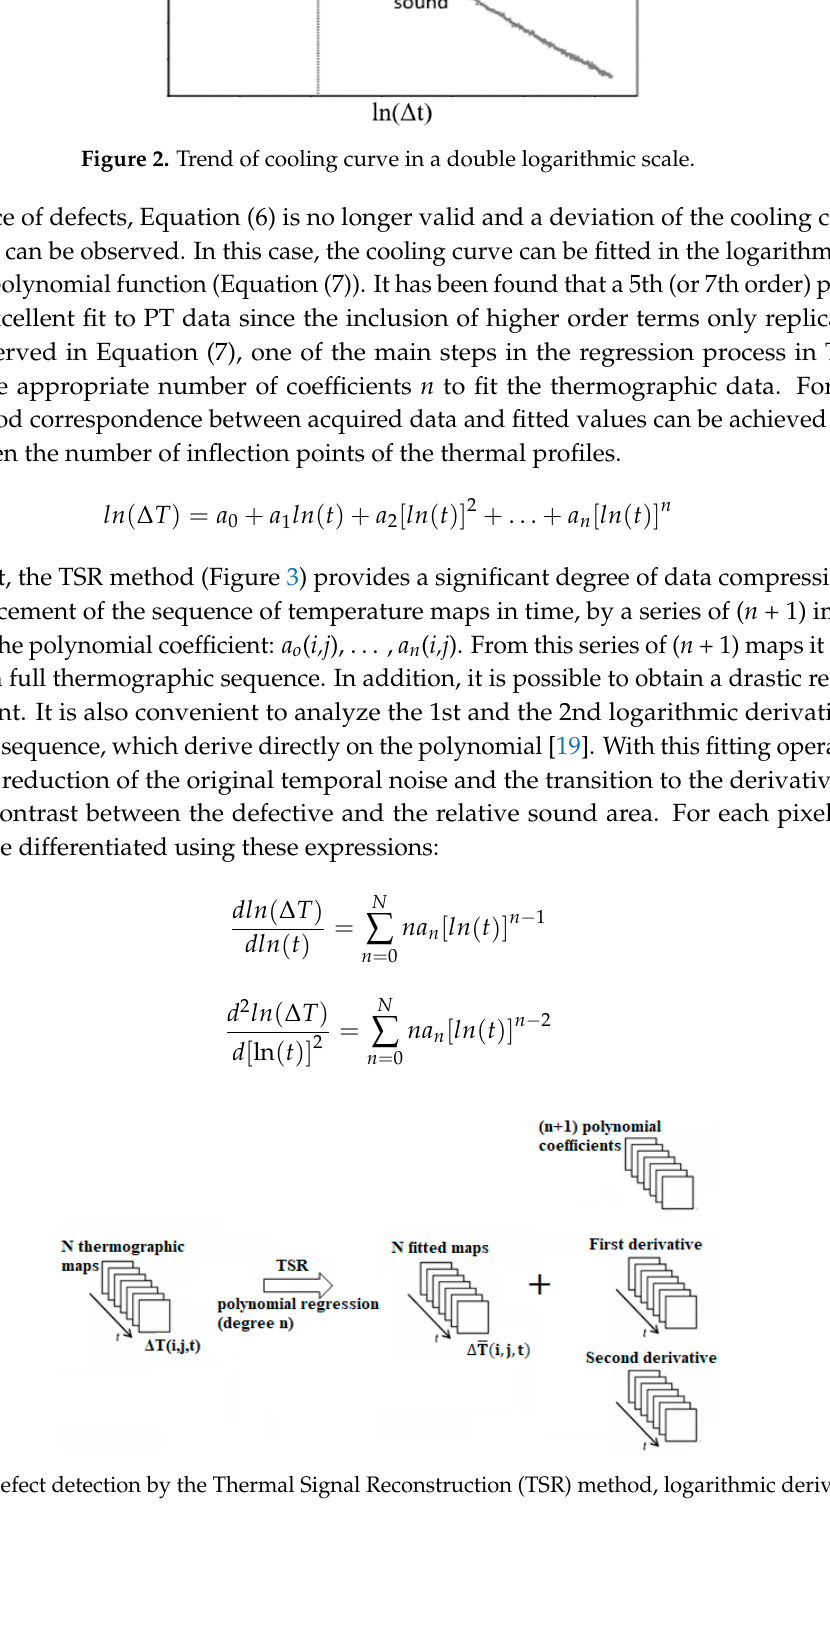
Figure 2. Trend of cooling curve in a double logarithmic scale.